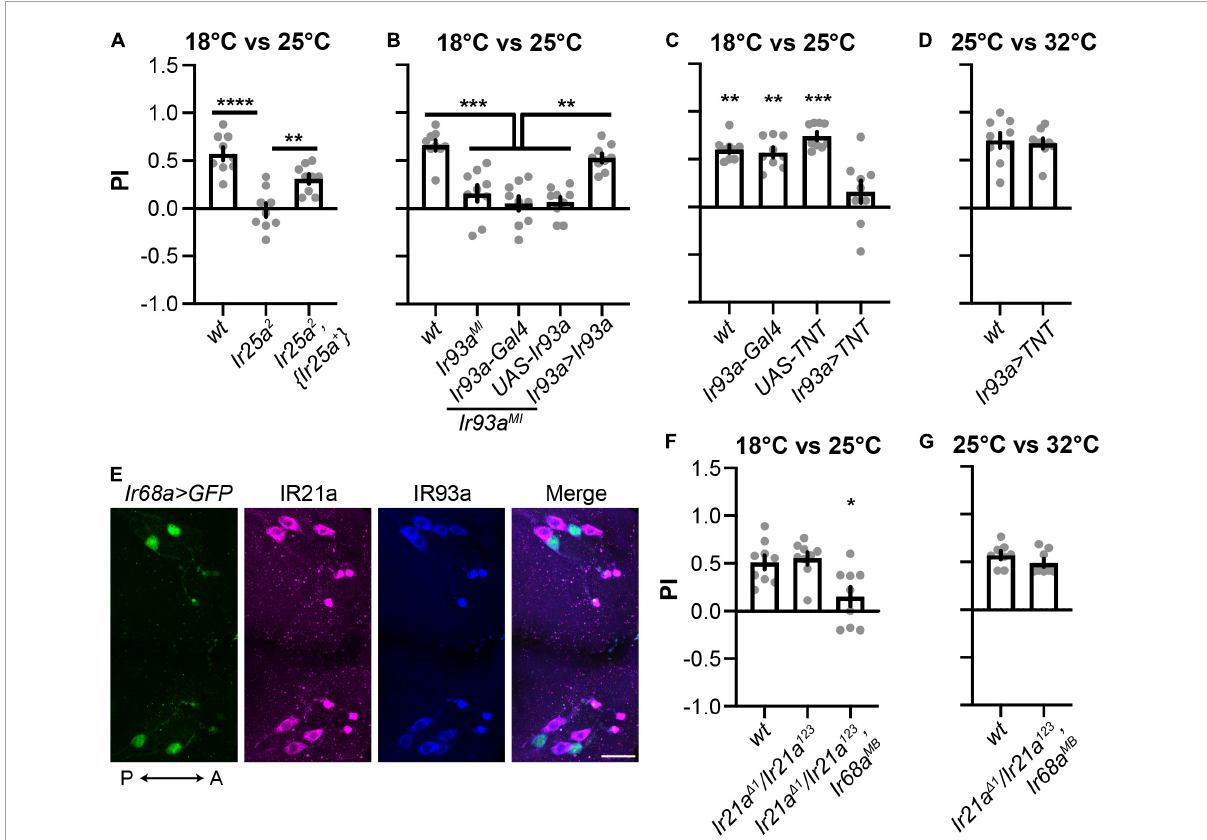
FIGURE3 Cool and warm IR receptors are both sufficient for cool preferences between 18 ◦ C and 25 ◦ C. (A,B) IR25a (A) and IR93a (B) are necessary for cool preferences between 18 ◦ C and 25 ◦ C. n = 9; data represent means ± s.e.m; ** P < 0.01, *** P < 0.001, and **** P < 0.0001, the Welch’s test of indicated groups. wt: CS ; Ir93a > Ir93a,Ir93a MI : Ir93a-Gal4,Ir93a MI /UAS-Ir93a,Ir93a MI . The same set of Ir25a 2 data was used as in Figure 1C . (C,D) Ir93a-Gal4 positive cells are required for cool preferences between 18 ◦ C and 25 ◦ C, but not between 25 ◦ C and 32 ◦ C. n = 9; data represent means ± s.e.m; ** P < 0.01 and *** P < 0.001, comparing to Ir93a > TNT ( UAS-TNT; Ir93a-Gal4 ), the Welch’s test, except the Mann–Whitney test for the comparison of UAS-TNT and Ir93a > TNT in (C) . (E) IR93a is expressed in five neurons in each DOG: two express Ir68a-Gal4, and the other three express IR21a. Immunostaining of GFP (green), IR21a (magenta), and IR93a (blue). The orientation is shown by double headed arrows. A, anterior; P, posterior. Scale bars, 20 µ m. Ir68a > GFP : Ir68a-Gal4/UAS-GFP . (F,G) The role of IR21a and IR68a in two-choice assays between 18 ◦ C and 25 ◦ C, as well as between 25 ◦ C and 32 ◦ C. n = 8–9; data represent means ± s.e.m; * P < 0.05, comparing PI with the corresponding wt ( CS ), the Welch’s test for (F) and the Mann–Whitney test for (G)